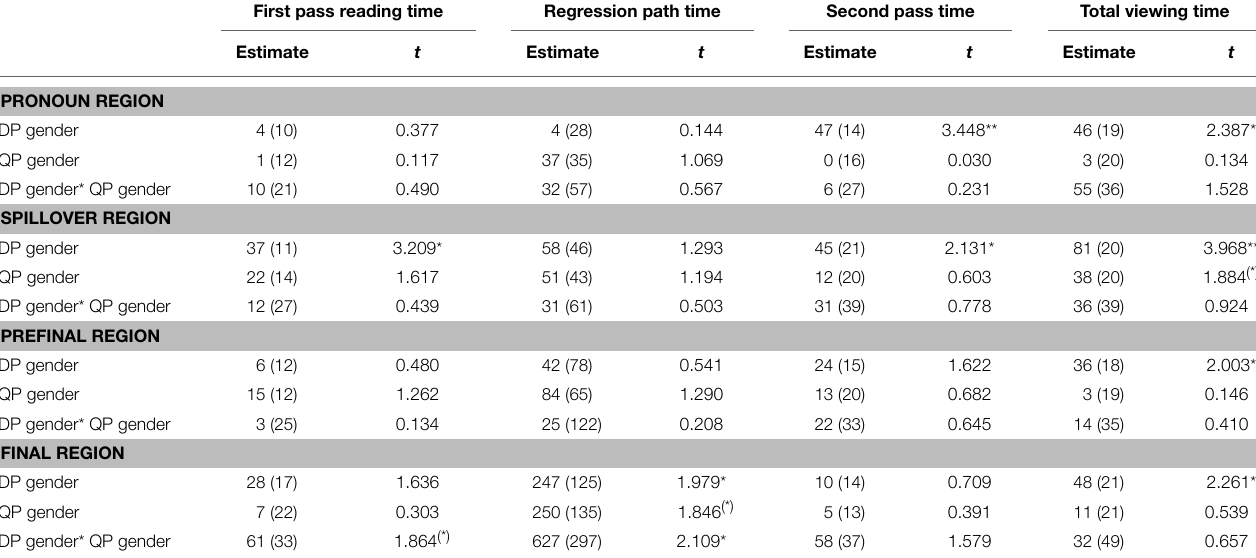
TABLE 6 | Summary of statistical analyses for four eye-movement measures at four regions of texts in Experiment 4. First pass reading time Regression path time Second pass time Total viewing